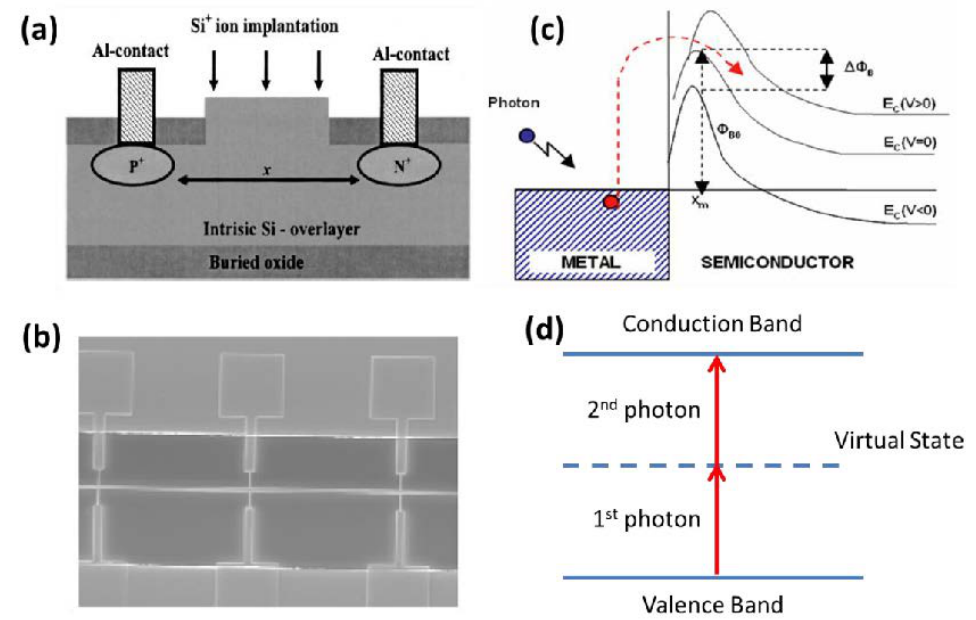
Figure 5: (a) A monolithic p − i − n all-Si photodetector based on the MBA mechanism. The defect states are introduced by ion implantation. (b) The SSA photodetector fabricated by Baehr-Jones et al. [116]. (c) Schematic of the IPE mechanism. (d) Schematic of the TPA mechanism. Figures with reprint permission from: (a) Ref. [105] ©2006 American Vacuum Society; (b) Ref. [116] ©2008 Optical Society of American; (c) Ref. [121] ©2008 Institute of